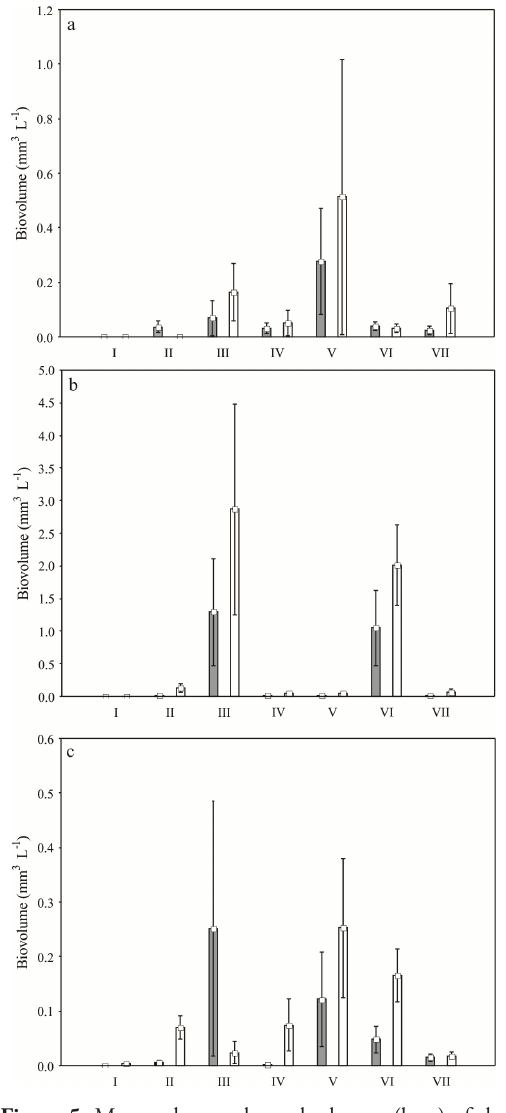
Figure 5. Mean values and standard error (bars) of the MBFGs biovolume in the lakes associated with the rivers: Paraná (a), Baia (b) e Ivinhema (c), in the dry (gray) and rainy (white) periods.